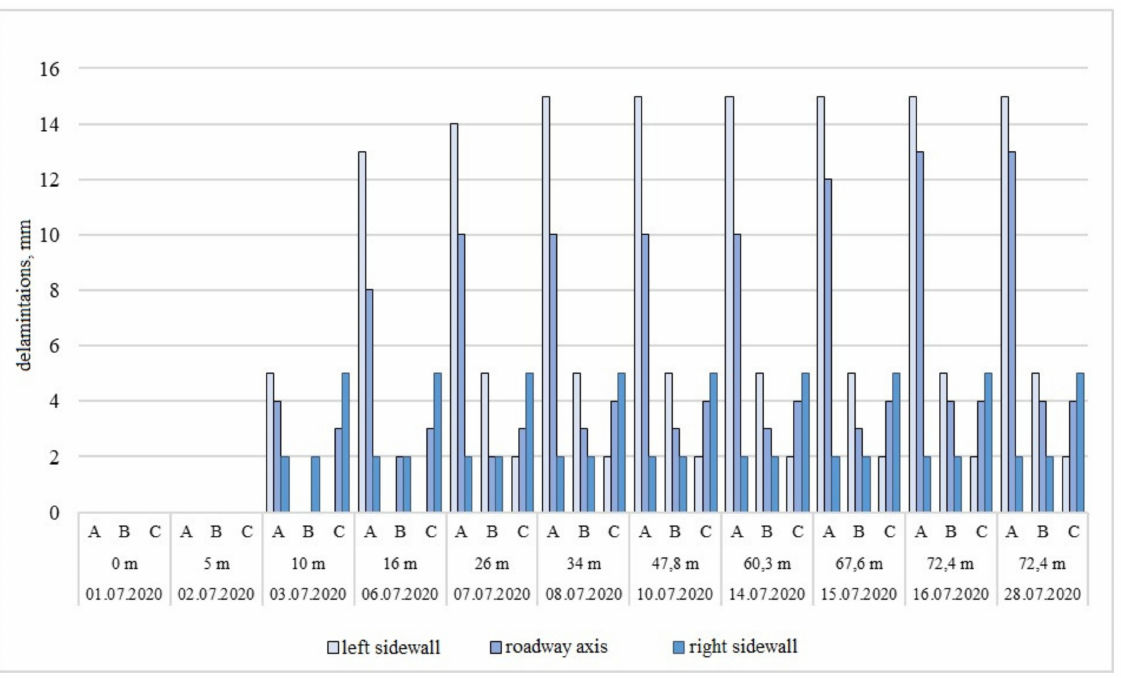
Figure 8. Roof delaminations’ values measured on the periodic control station no.